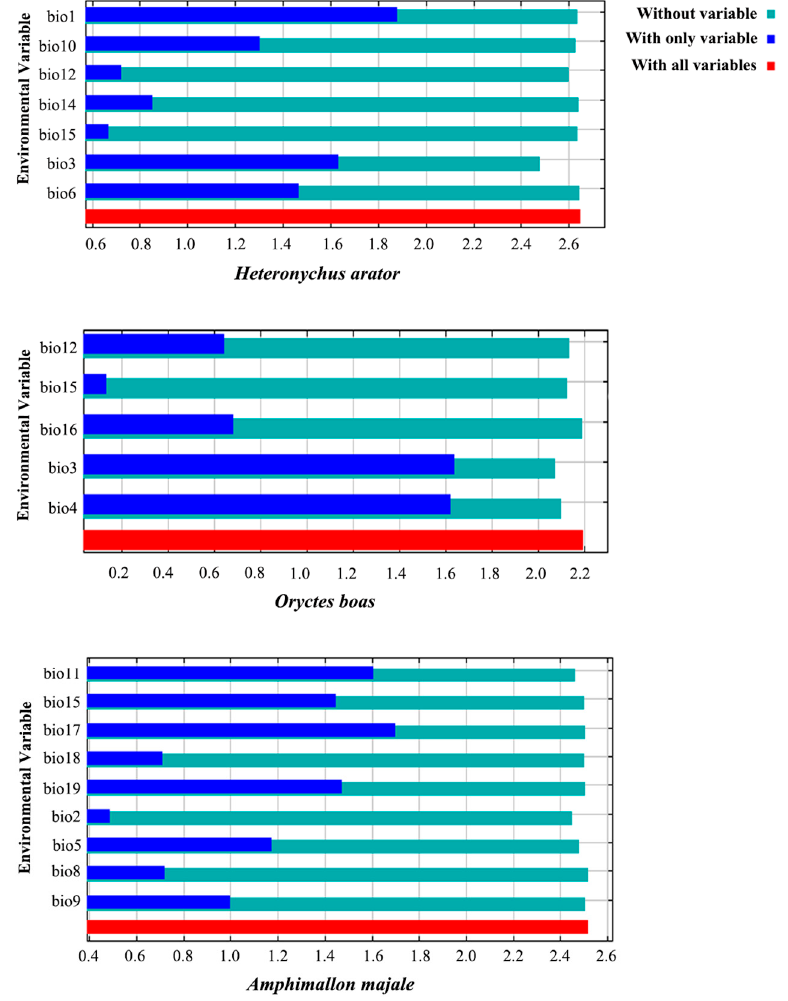
Figure 2. Jackknife test results of bioclimatic variables importance for Heteronychus arator , Oryctes boas and Amphimallon majale . Green, blue and red bars represent running the MaxEnt model without the variable alone, with only variable, and with all variables, respectively.